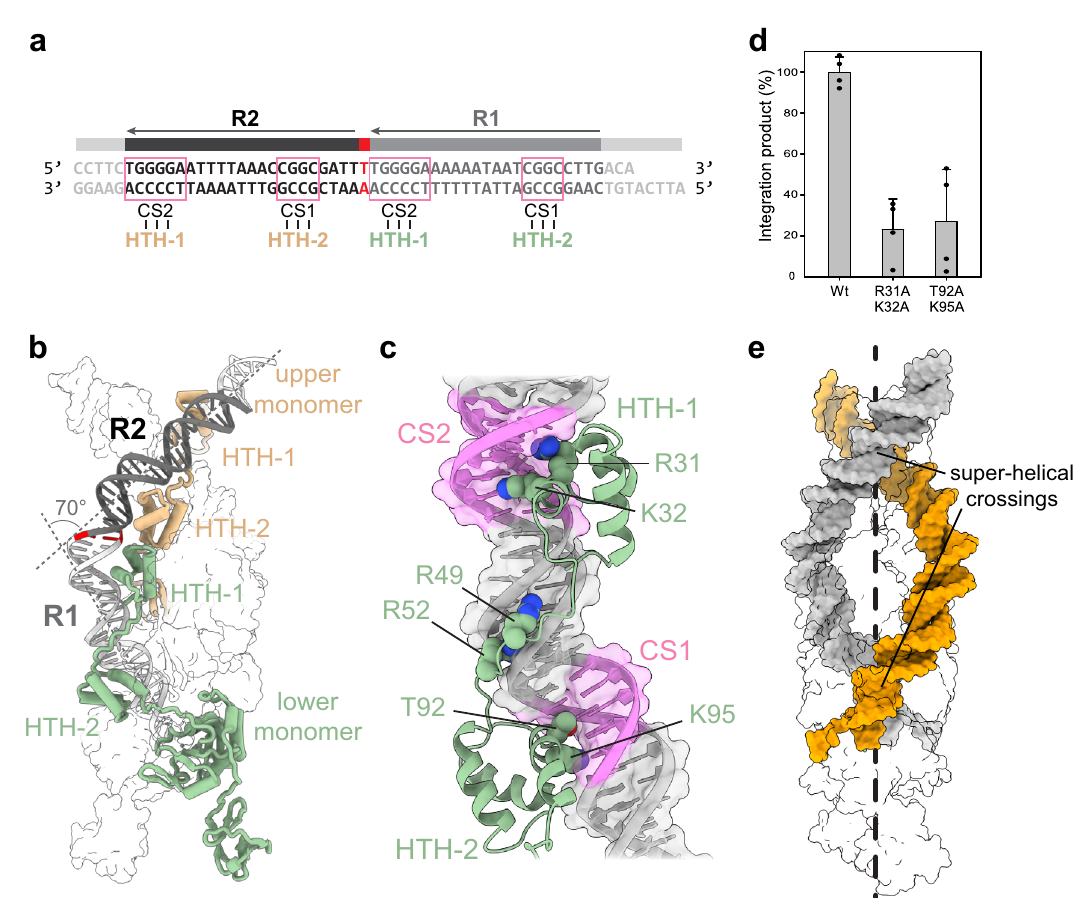
Fig. 6 | IstA bends and twists two transposon ends into a negative superhelix. a Details of the right transposon end sequence used for the structural analysis. b The two catalytic monomers of the IstA tetramer (chains A and B) interact with the R1 repeat or a TIR while the upper structural subunits (chains C and D) engage the R2 sequence. Half of the complex is shown as a transparent surface for clarity. c The HTH domains of the lower and upper monomers use the same residues to interact with equivalent nucleotides in the R1 and R2 repeats. d Double alanine